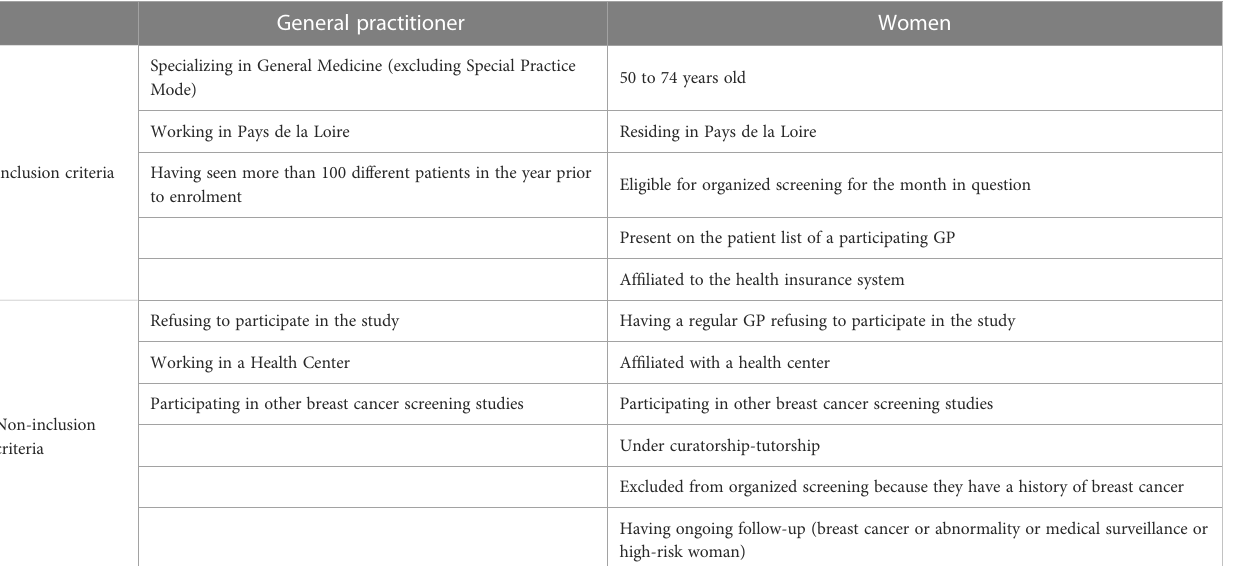
TABLE 1 Inclusion and exclusion criteria for GPs and